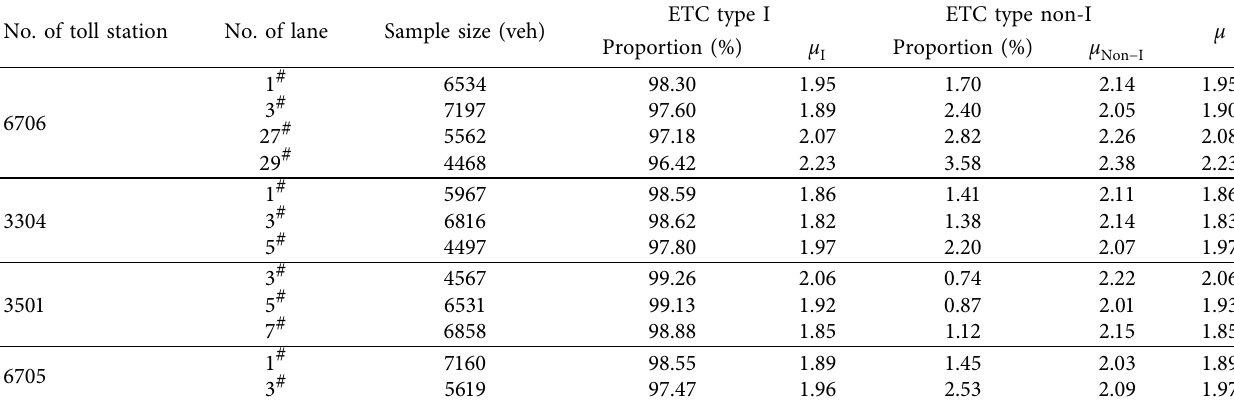
Table 3: Fitting parameters for the lognormal distribution of service time when ETC entrances of toll stations are saturated. No. of toll station